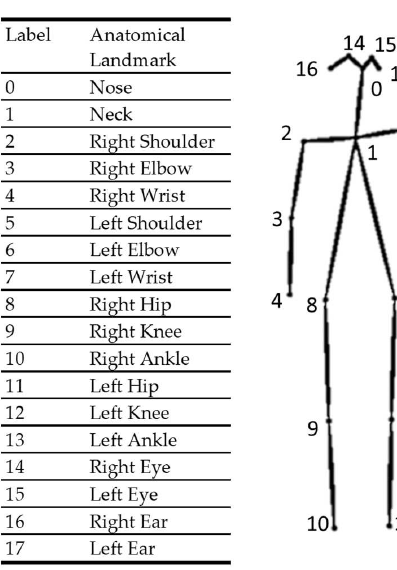
Figure 2. The anatomical landmarks generated by the pose estimator (OpenPose).